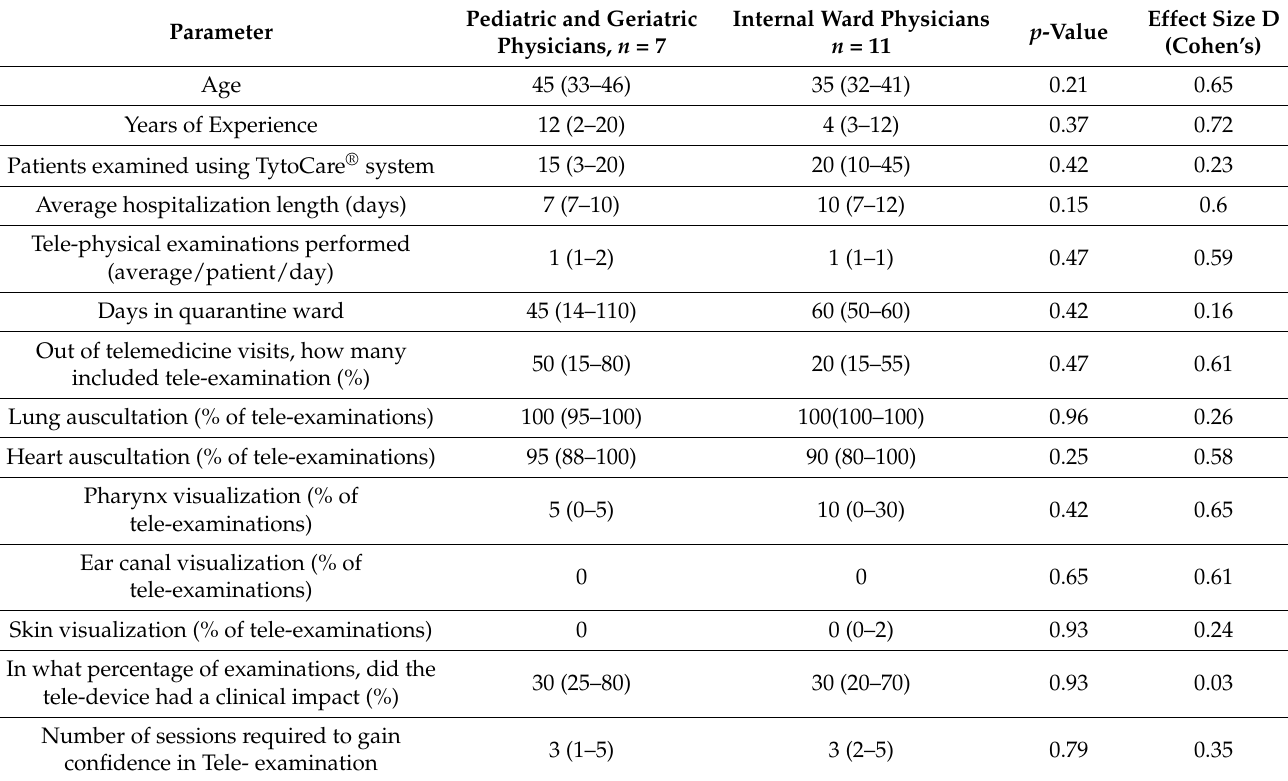
Table 4. Volume and characteristics of use with regard to physicians’